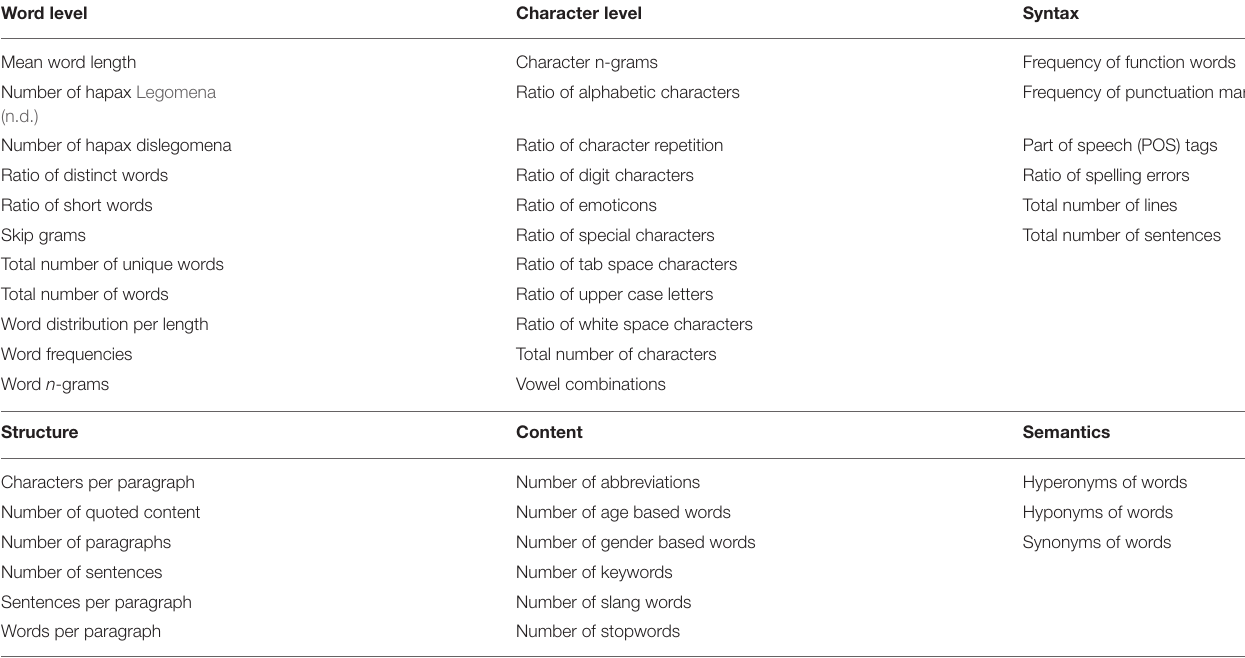
TABLE 1 | Frequently used features for text analysis as categorized by Tsapatsoulis and Djouvas